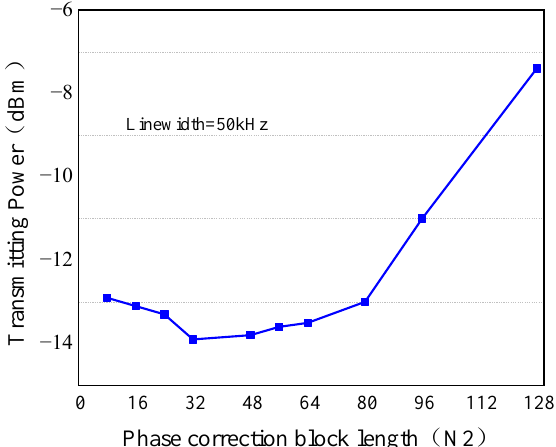
Figure 6. Transmitting power as a function of different N2 values.